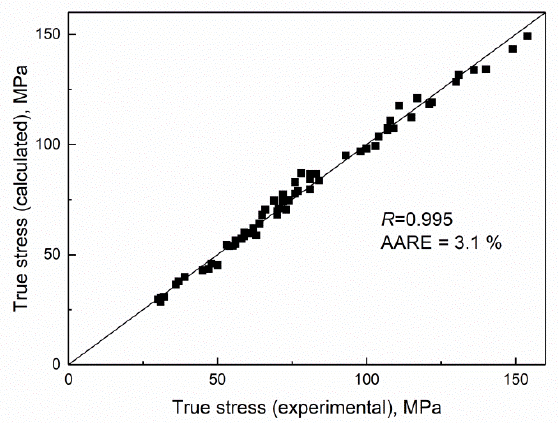
Figure 3. Comparison between the predicted and the experimental values of the flow stress.